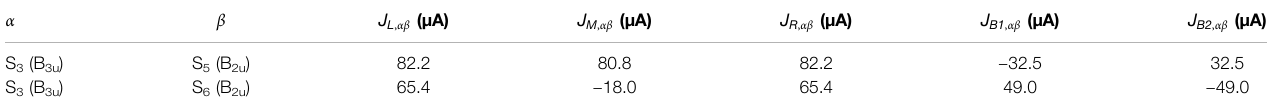
L (R) indicate the left (right)-hand side ring, M corresponds to the middle ring. Here a positive current denotes that the ring current fl ows (the π -electron rotates) in an anti-clockwise (clockwise) direction. Reprinted with permission from Ref. [42] Copyright (2017) American Institute of